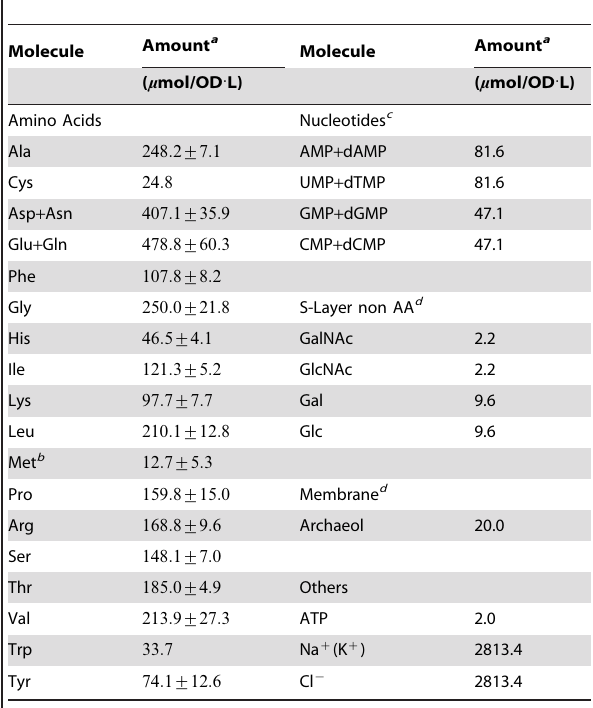
Table 1. Major components of the N. pharaonis